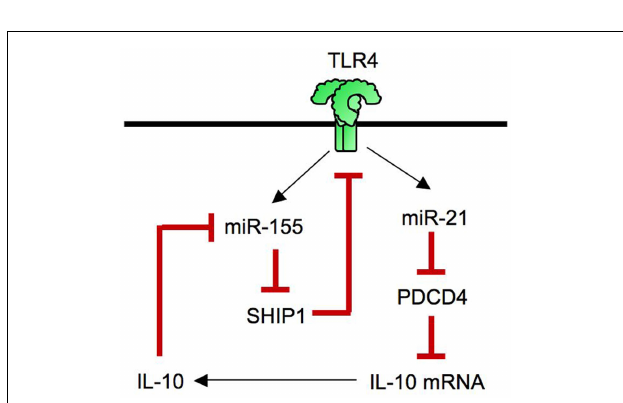
FIGURE 3 | Negative regulation ofTLR signaling by miRNA. miR-146 negatively regulates the expression of IRAK1, IRAK2, andTRAF6. miR-21 negatively regulates the expression of a IL-12 p35 subunit. miR-155 inhibits